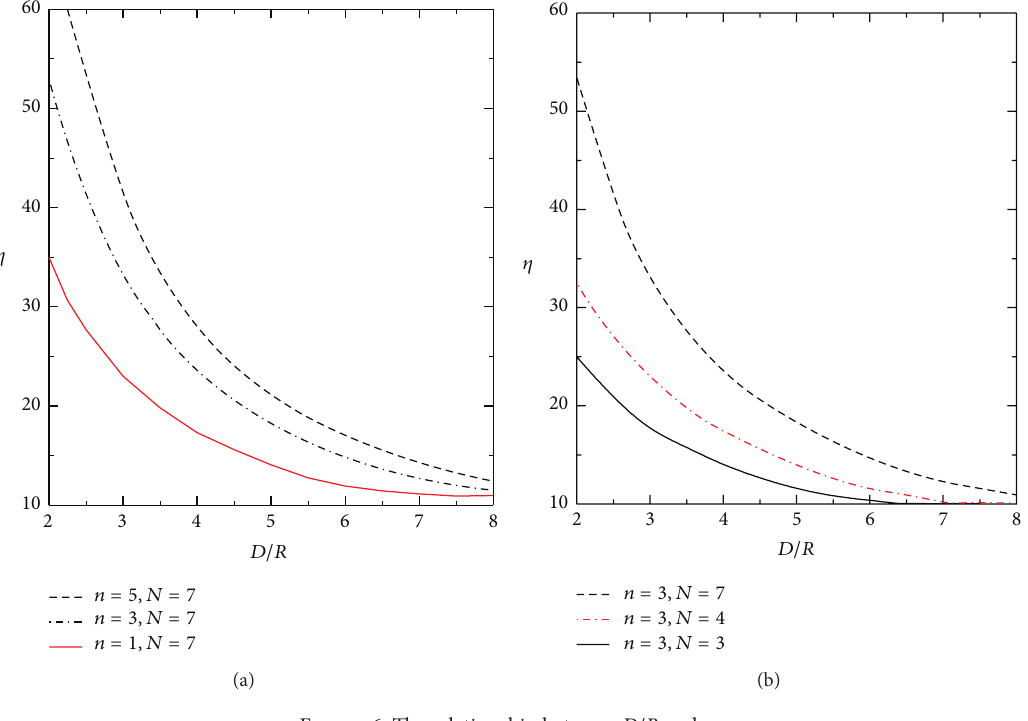
Figure 6: The relationship between D / R and 𝜂